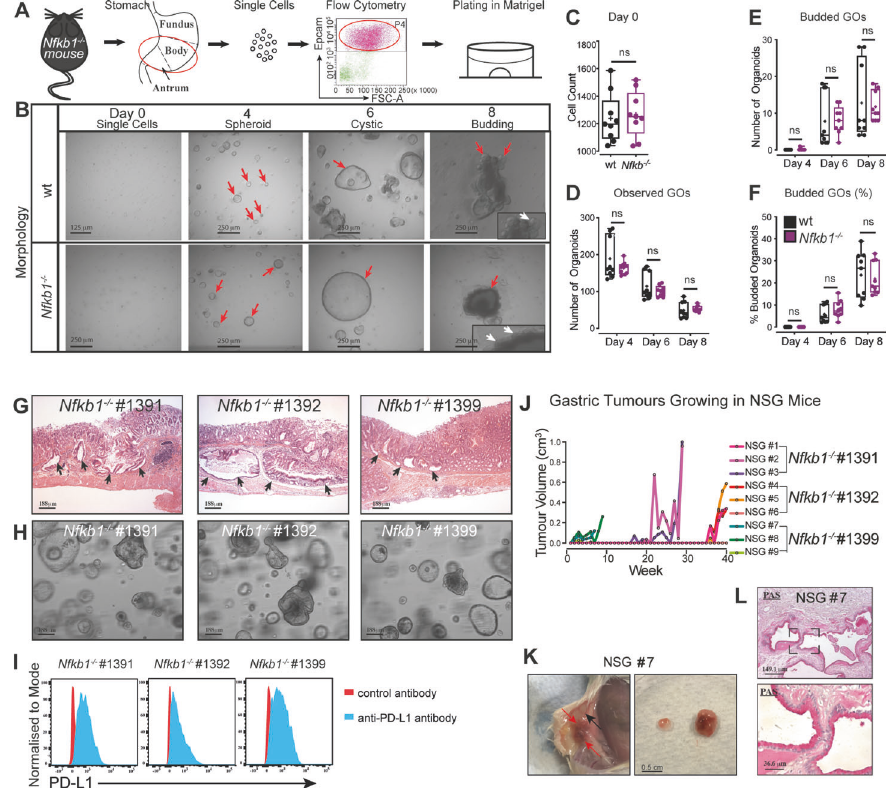
Fig. 1 Establishment of gastroids of pre-neoplastic Nfkb1 − / − mice and PD-L1 expressing TGOs from GC of old sick Nfkb1 − / − mice. A Schematic for the culture of gastric epithelial cells. B Representative images of GO cultures showing morphologies (arrows). Graphical representation of C cell counts of sorted gastric epithelial cells, D GOs observed, inclusive of all spheroid, budding and cystic organoids E budding GOs and F budding GOs represented as a percentage of total observed GOs. G H&E stained sections of GCs from Nfkb1 − / − mice used to derive TGOs. Arrows indicate dysplasia or invasion. H Representative images of TGOs established from GC of Nfkb1 − / − mice. I Histogram showing PD-L1 expression on cells isolated from Nfkb1 − / − TGOs. J Tumor growth from subcutaneous injection of TGOs. Each line represents measurements from a single mouse. K Representative harvest of subcutaneous tumours derived from injected TGOs. Red arrows = tumour, black arrows = vascularisation. L Representative images of PAS staining (magenta) in transplanted TGOs. C – F Mean + / = SE (student ’ s T -test), N = 3 experimental repeats each with 3